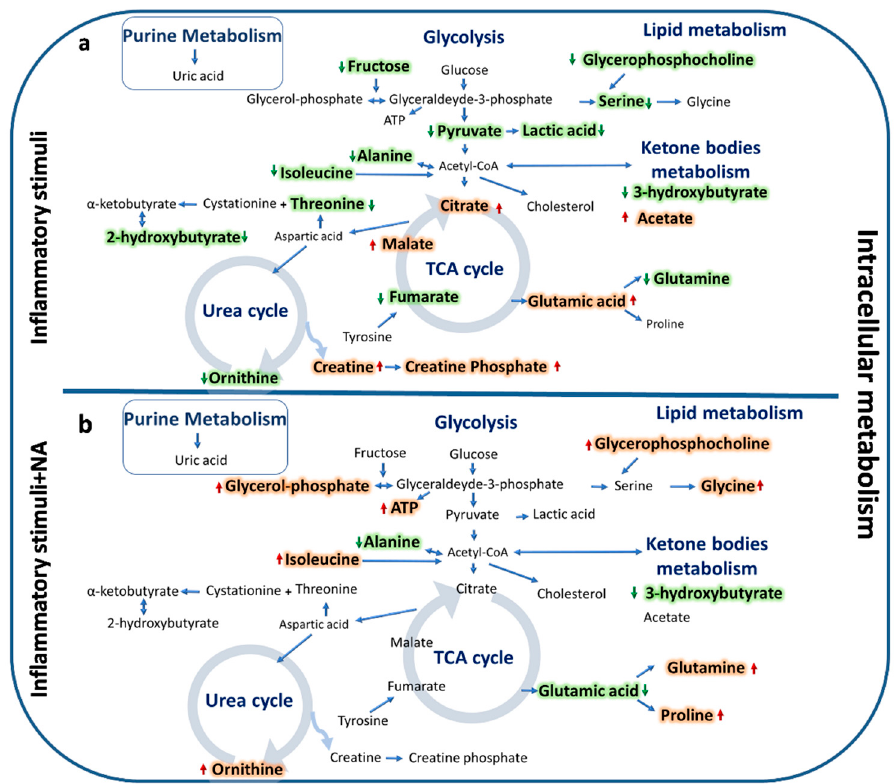
Figure 5. Relevant metabolic pathways that were found significantly altered after treatment with proinflammatory stimuli (LPS and IL-1 β ) ( a ) and after treatment with proinflammatory stimuli in combination with NA ( b ) in Caco-2 cells at the intracellular level. Increased and decreased metabolites are highlighted in red and green, respectively.